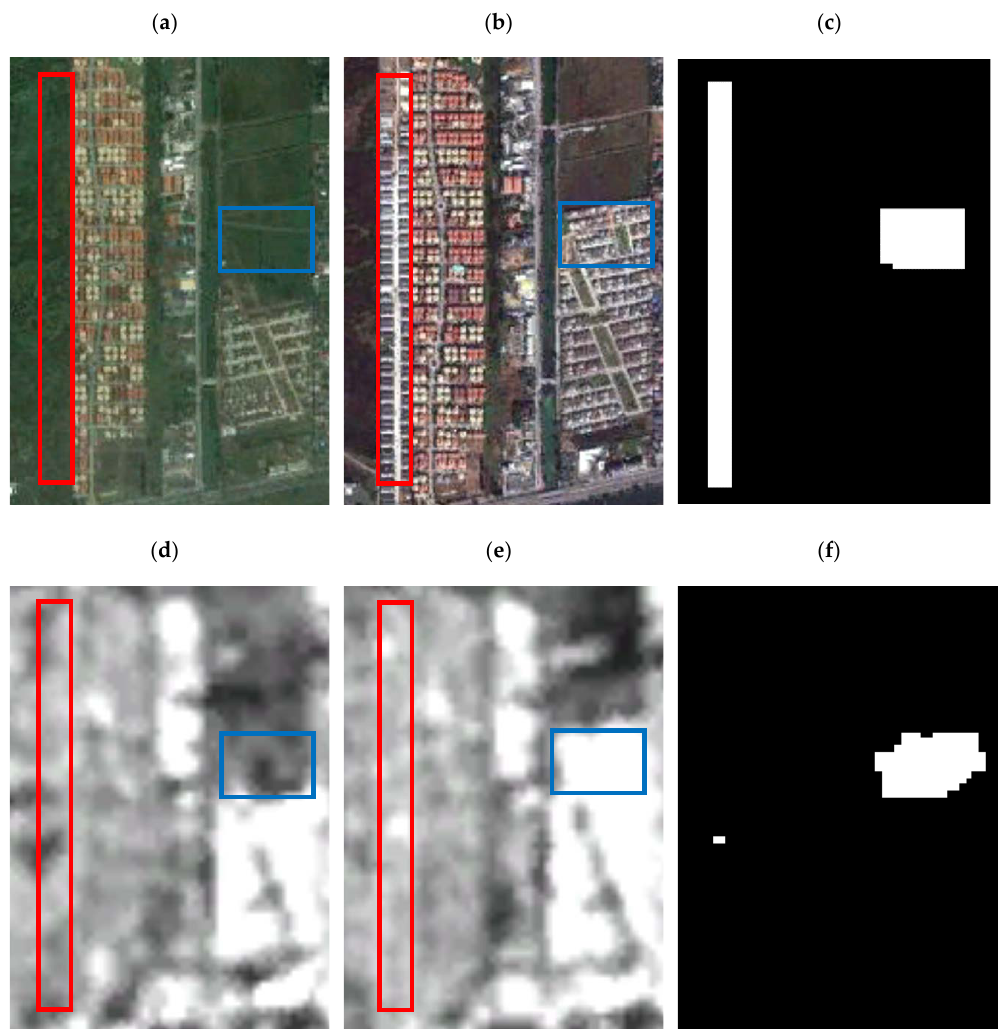
Figure 18. Example of successful detection and failed detection: ( a ) optical image from 22 August 2008, ( b ) optical image from 15 April 2010, ( c ) ground truth, ( d ) SAR image from 27 November 2008, ( e ) SAR image from 15 January 2010, ( f ) result of the model (the resolution of each image is 1 km × 0.75 km).